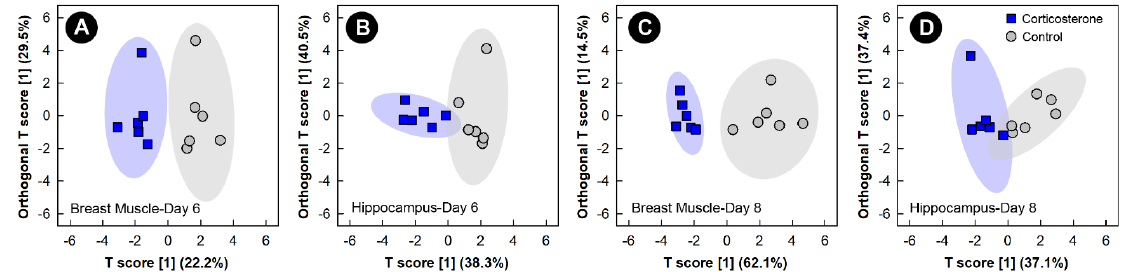
Figure 3. Orthogonal Partial Least Squares Discriminant Analysis (OPLS-DA) score plots of breast muscle and the hippocampus metabolome of chicks administered corticosterone in their diet, or provided a diet free of glucocorticoid (control treatment), created using the spectral bins that were determined to be altered ( p ≤ 0.050) by Variable Importance Analysis, based on random Variable Combination (VIAVC) analysis, and/or the univariate Mann–Whitney U test. ( A ) Breast muscle at day 6; ( B ) hippocampus at day 6; ( C ) breast muscle at day 8; and ( D ) hippocampus at day 8. The x - and y -axis in the OPLS-DA plots represent the predictive (between-group separation) and orthogonal (within-group variation) components of the data, respectively. Each marker represents one bird ( n = 6 per treatment), and shaded ellipsoids are the 95% confidence intervals for each treatment.